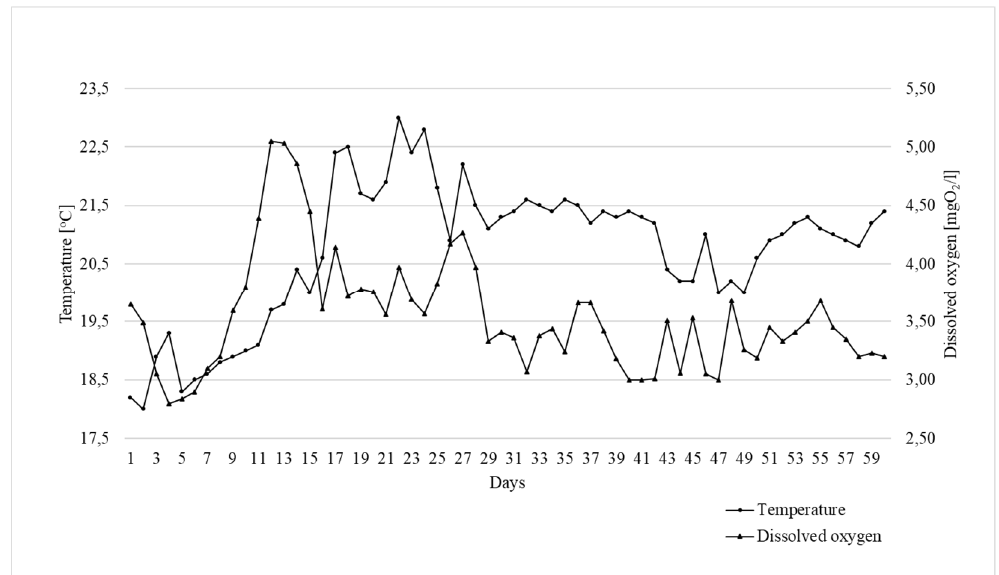
◦ C) and dissolved oxygen (mgO